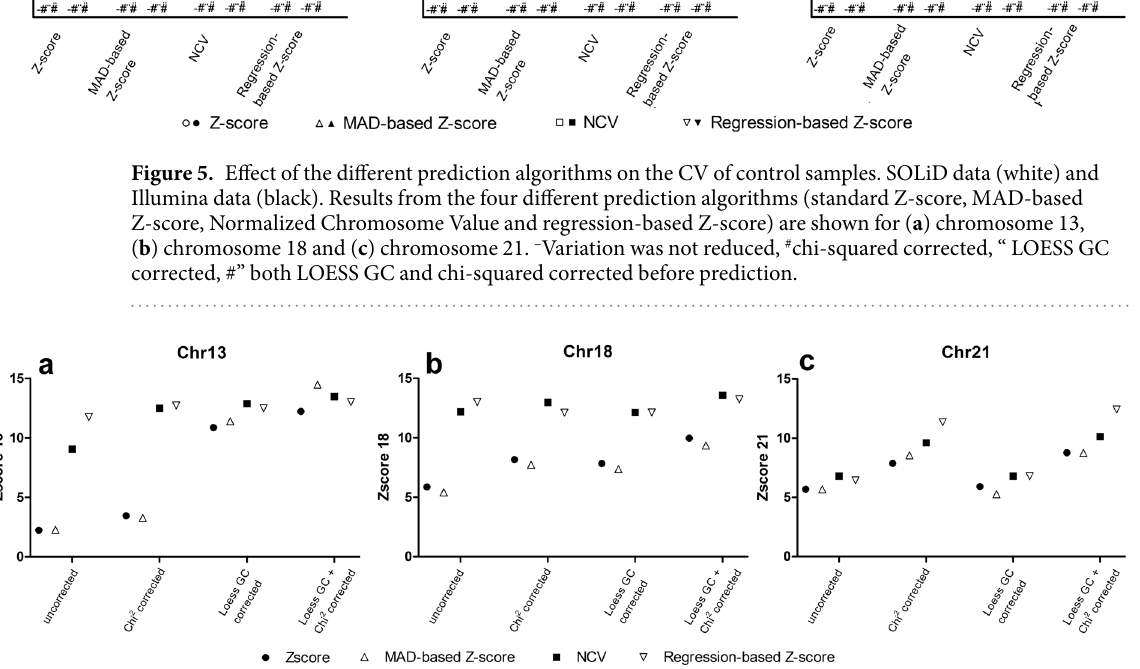
Figure 6. Z-scores for three trisomies using different combinations of variation reduction and prediction algorithms. All three examples are based on SOLiD data. Results from the four different prediction algorithms (standard Z-score, MAD-based Z-score, Normalized Chromosome Value, and regression-based Z-score), in combination with uncorrected, chi-squared corrected, LOESS GC corrected, and both LOESS GC and chi- squared corrected are shown for ( a ) chromosome 13, ( b ) chromosome 18 and (c) chromosome